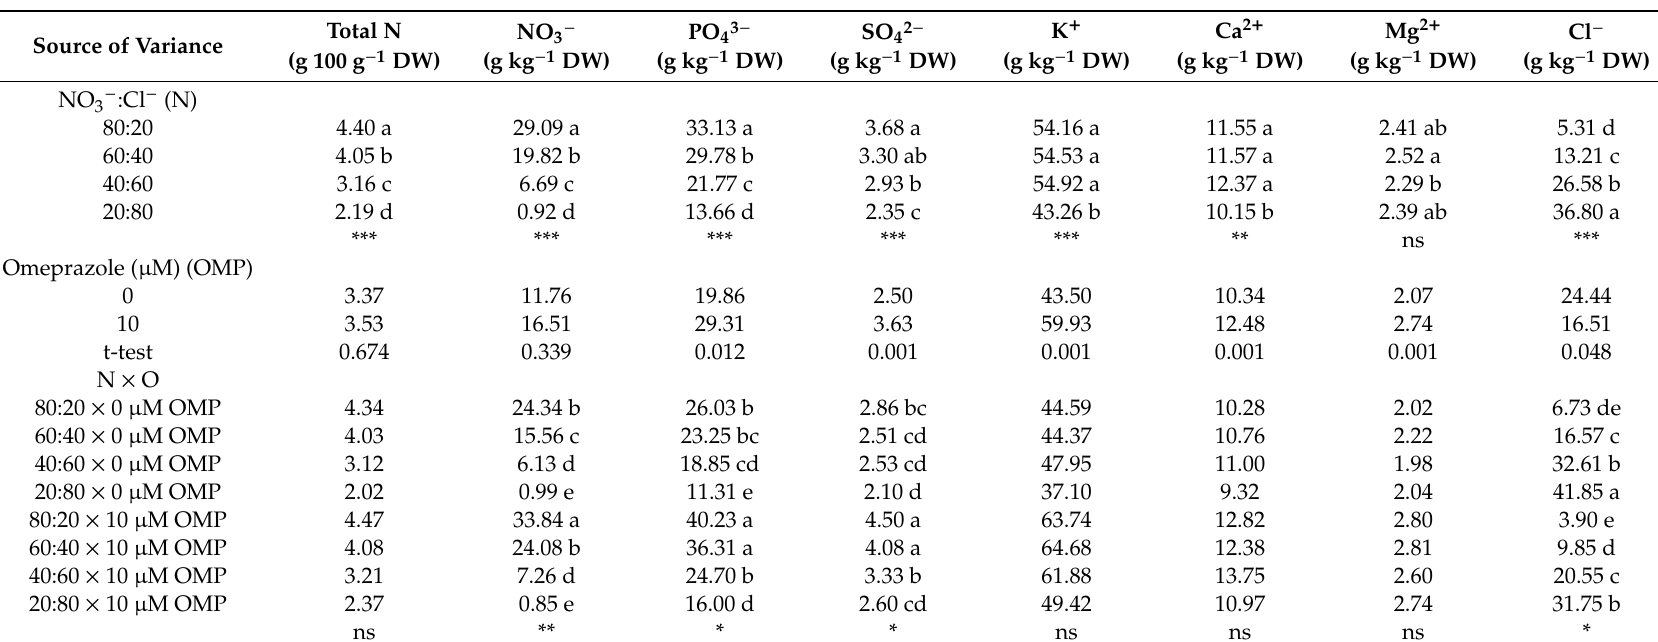
Table 3. E ff ects NO 3 − :Cl − ratio in the nutrient solution and omeprazole (OMP) application rates on total nitrogen (N), nitrate (NO 3 − ), phosphate (PO 43 − ), sulphate (SO 42 − ), potassium (K + ), calcium (Ca 2 + ), magnesium (Mg 2 + ), chloride (Cl − ). Source of